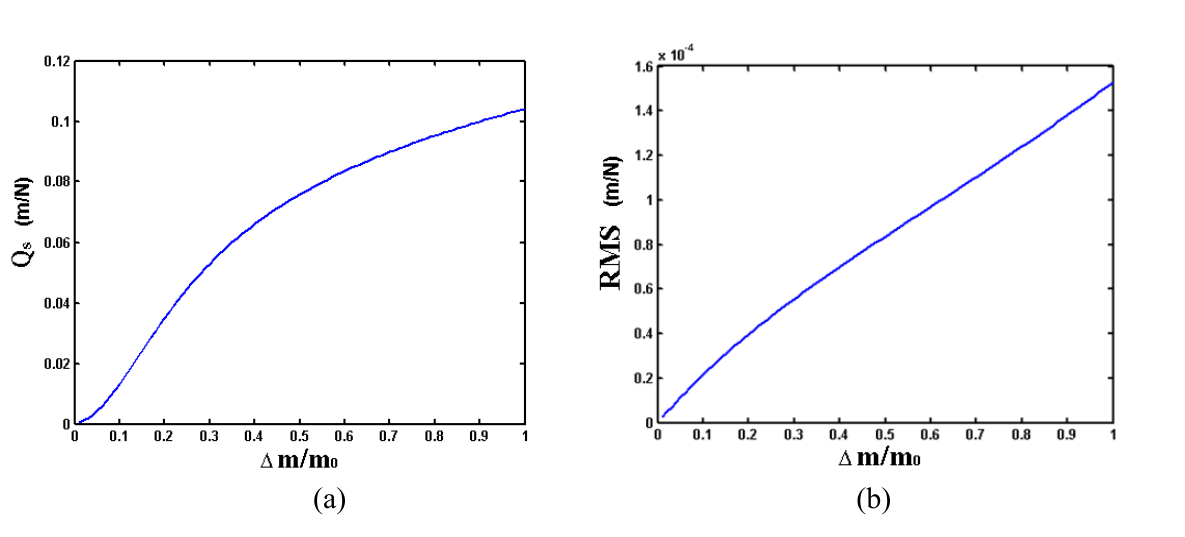
Figure 14. Comparison of Q